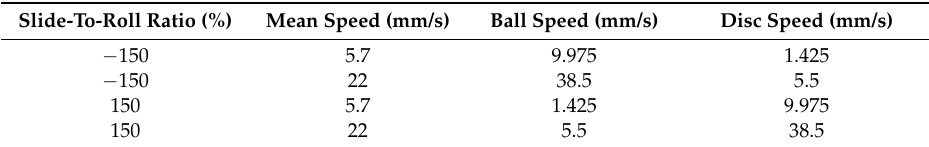
Table 4. A detailed overview of the kinematic